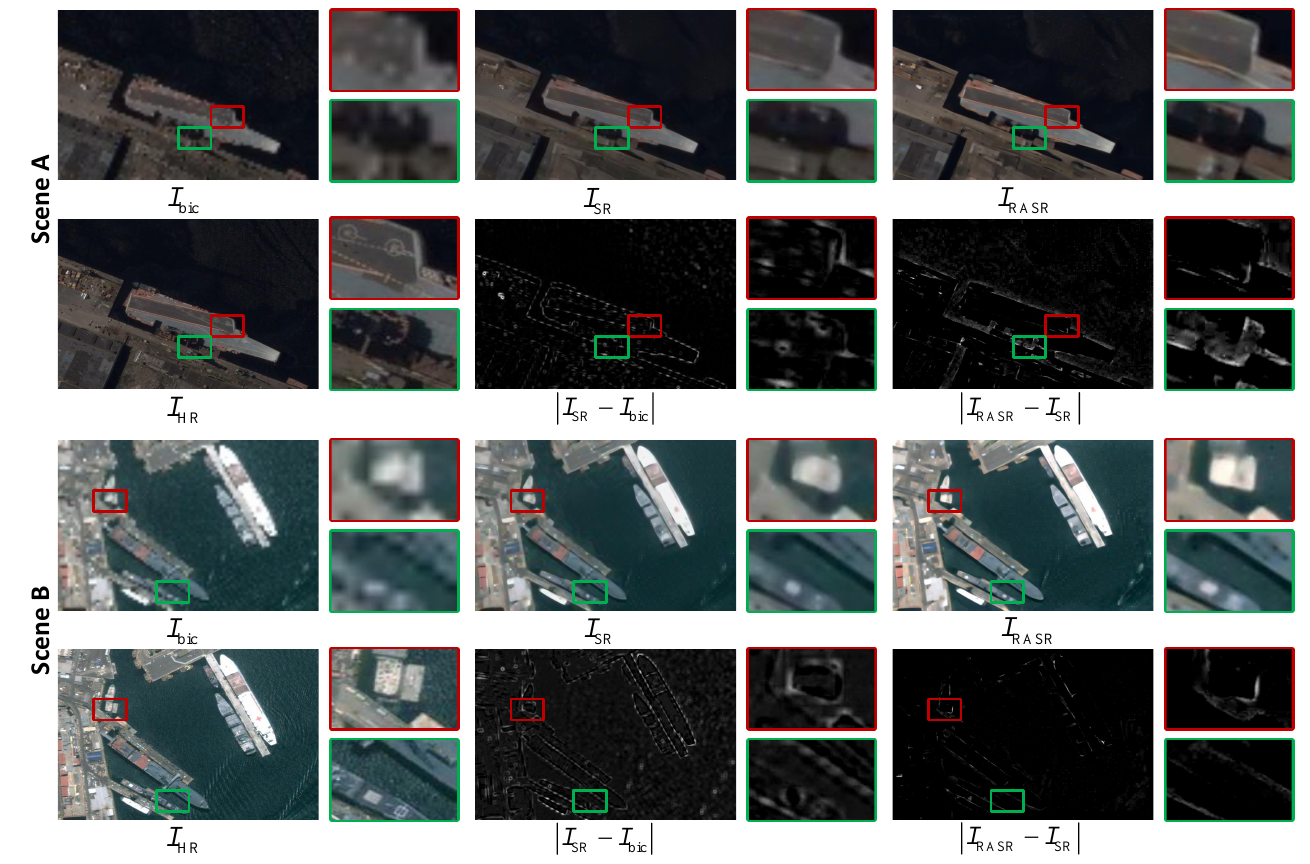
Figure 3. Visualizations of the original HR image ( I HR ) and the super-resolved images using different SR methods: bicubicly up-sampling ( I bic ), SR module ( I SR ) and RASR method ( I RASR ). Furthermore, the absolute difference of I RASR , I SR and I bic is